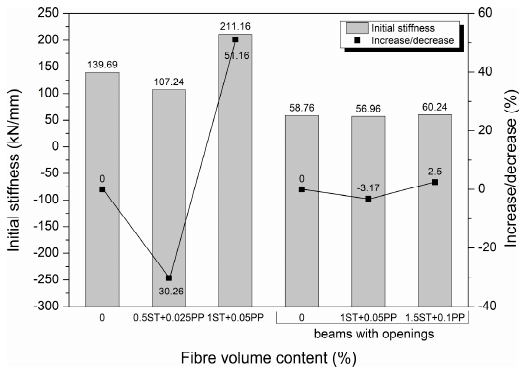
Figure 5. Comparison of beam initial stiffness.